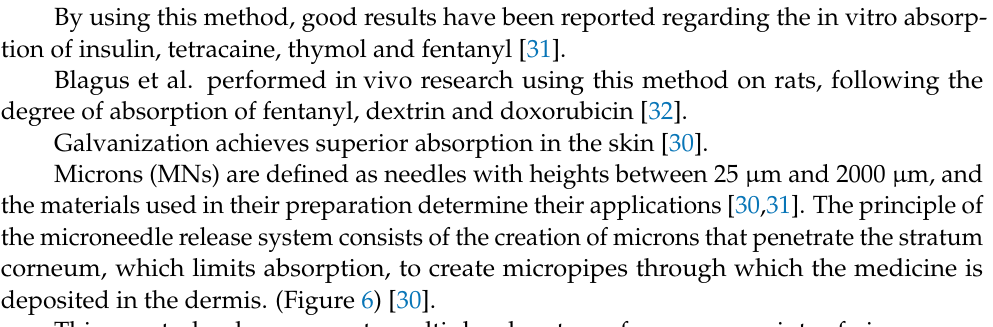
Figure 5. Schematic diagram showing pulse wave transdermal drug delivery [30].